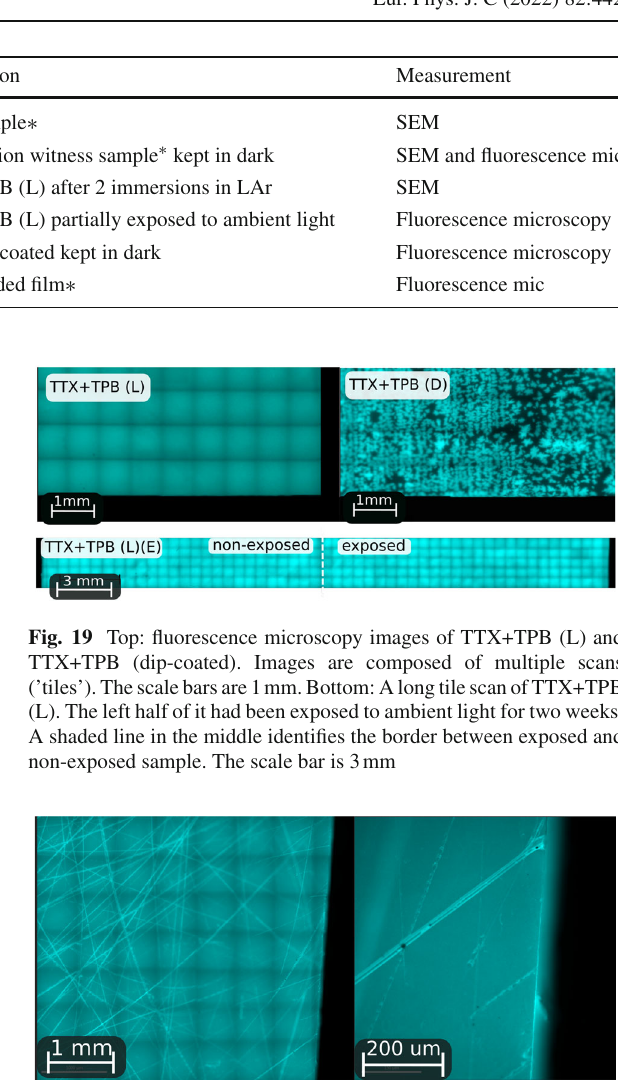
Fig. 20 Fluorescence microscopy images of PEN. A tile scan is shown on the left and a single scan on the right. The scale bars are 1mm and 200 µ m